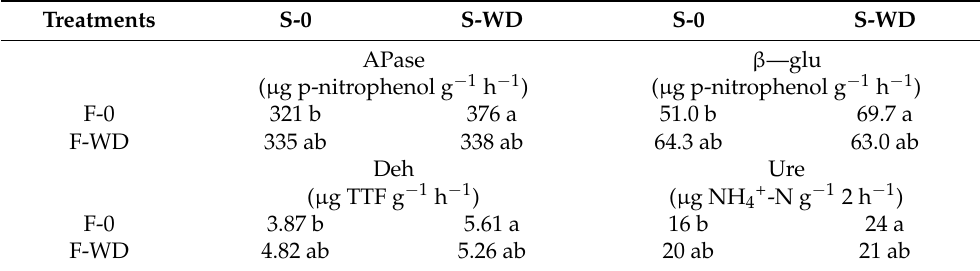
Table 3. Soil enzyme activities as affected by the interaction of wood distillate (WD) distribution as foliar spray (F) and soil irrigation (S). APase, alkaline phosphatase; β —glu, β —glucosidase; Deh, dehydrogenase; Ure, urease. Data are means of three replicates ( n = 3). For each enzyme activity, same letters indicate not significantly different means at p ≤ 0.05, Tukey test.